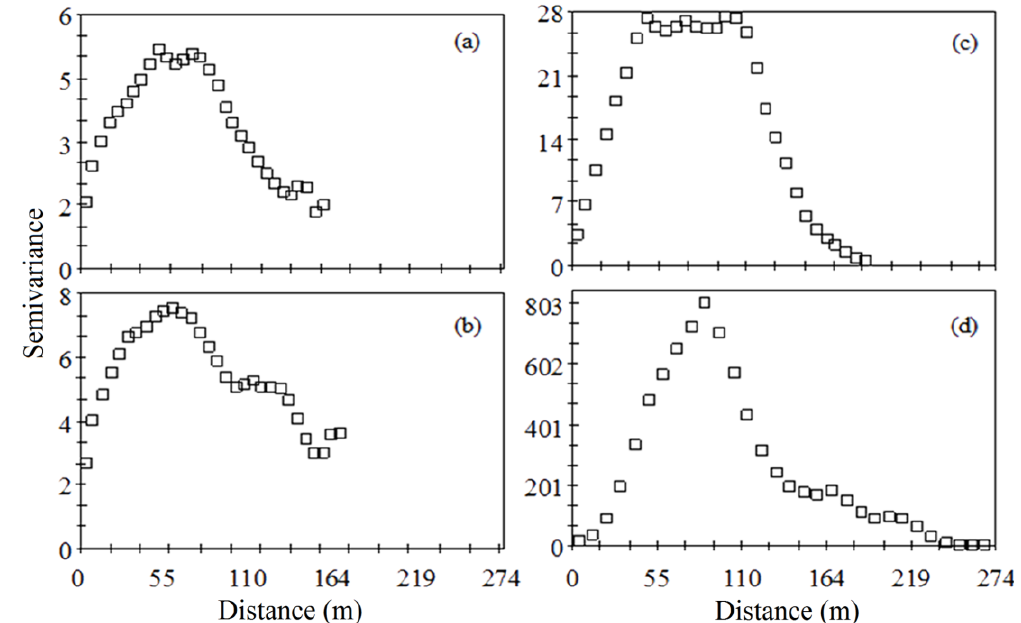
Figure 4. Overall semivariograms of the areas of Thiessen polygons around dung patches in paddocks grazed at di ff erent intensities by steers. Grazing intensities were given by the sward heights of ( a ) 0.1 m, ( b ) 0.2 m, ( c ) 0.3 m and ( d ) 0.4 m on mixed black oat ( Avena strigosa Schreb.) and Italian ryegrass ( Lolium multiflorum Lam.) pastures at the end of the stocking period of an integrated soybean-beef cattle system in southern Brazil.